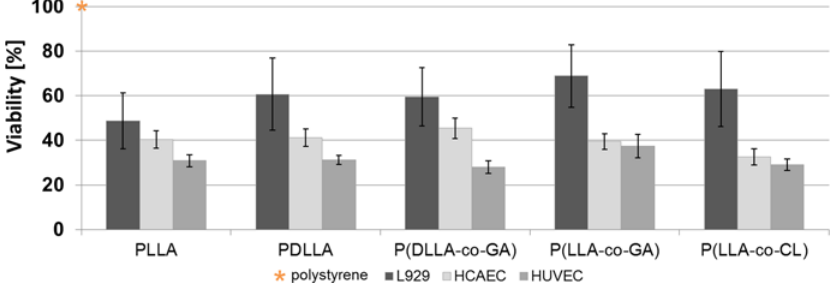
Fig 3. Cell viability measurements of three different cell types. Relative cell viability after 72 h growth on unmodified polymer surfaces, n = 6 (for each cell type). Orange star indicates the viability of cells on polystyrene (control), which was set to 100% (asteric). Data are presented as mean of three independent experiments ± SEM.